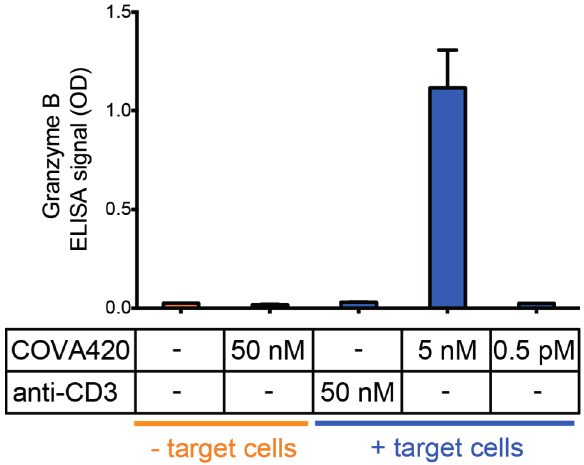
Figure 2. Granzyme B release into the cell culture supernatant was evaluated by ELISA. Controls were used at the highest assay concentration. For COVA420 concentrations where maximal cytotoxicity (5 nM) or no cytotoxicity (0.5 pM) was observed were analyzed. Results are shown as mean ELISA signal ±